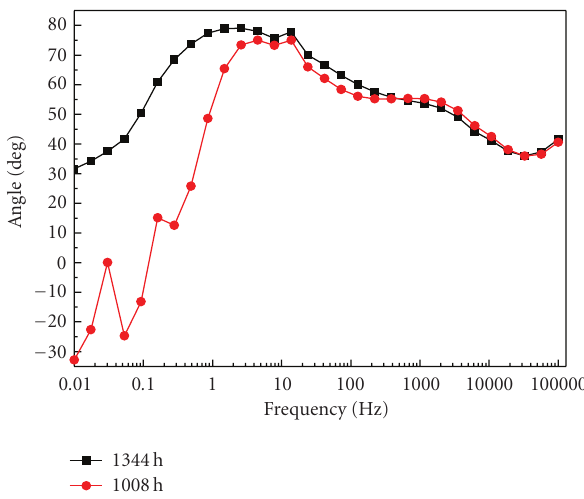
Figure 8: EIS of scratched coated samples after 1008-hour and 1344-hour exposure